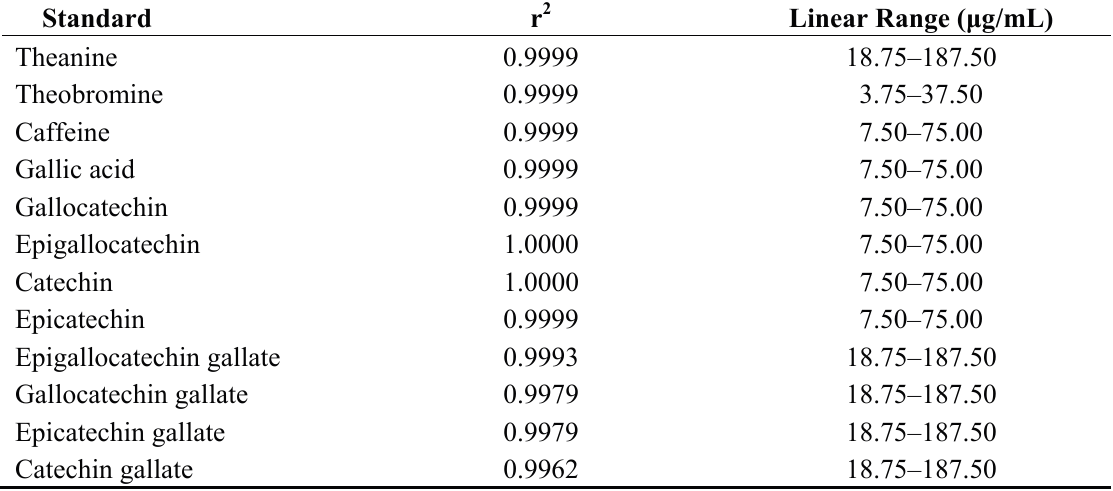
Table 4. Calibration data for external standards using the